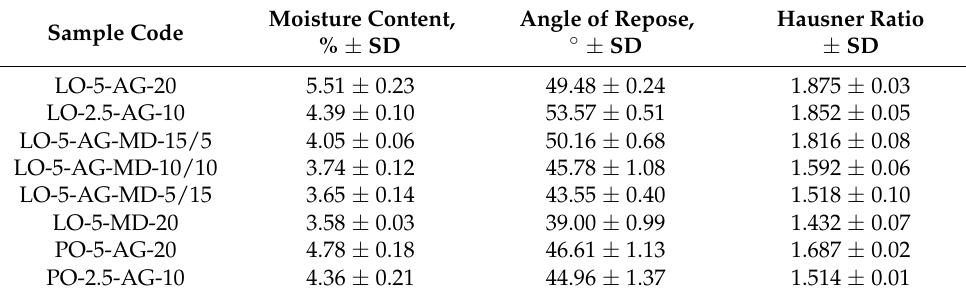
Table 5. Moisture content and flow properties of the developed microparticles ( n =